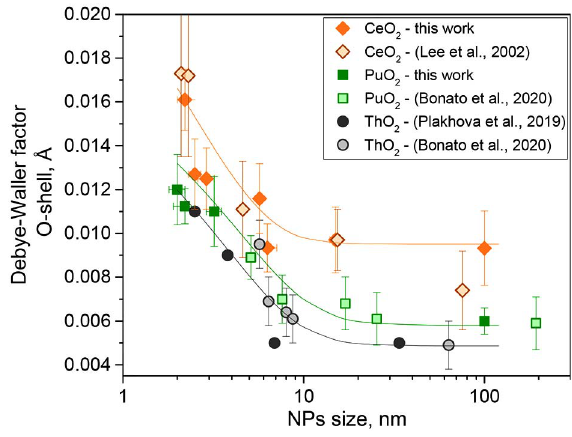
Figure 2 Dependence of the DWF of the first coordination shell (Me–O) with the average NP size from the results of this work and previously published data.